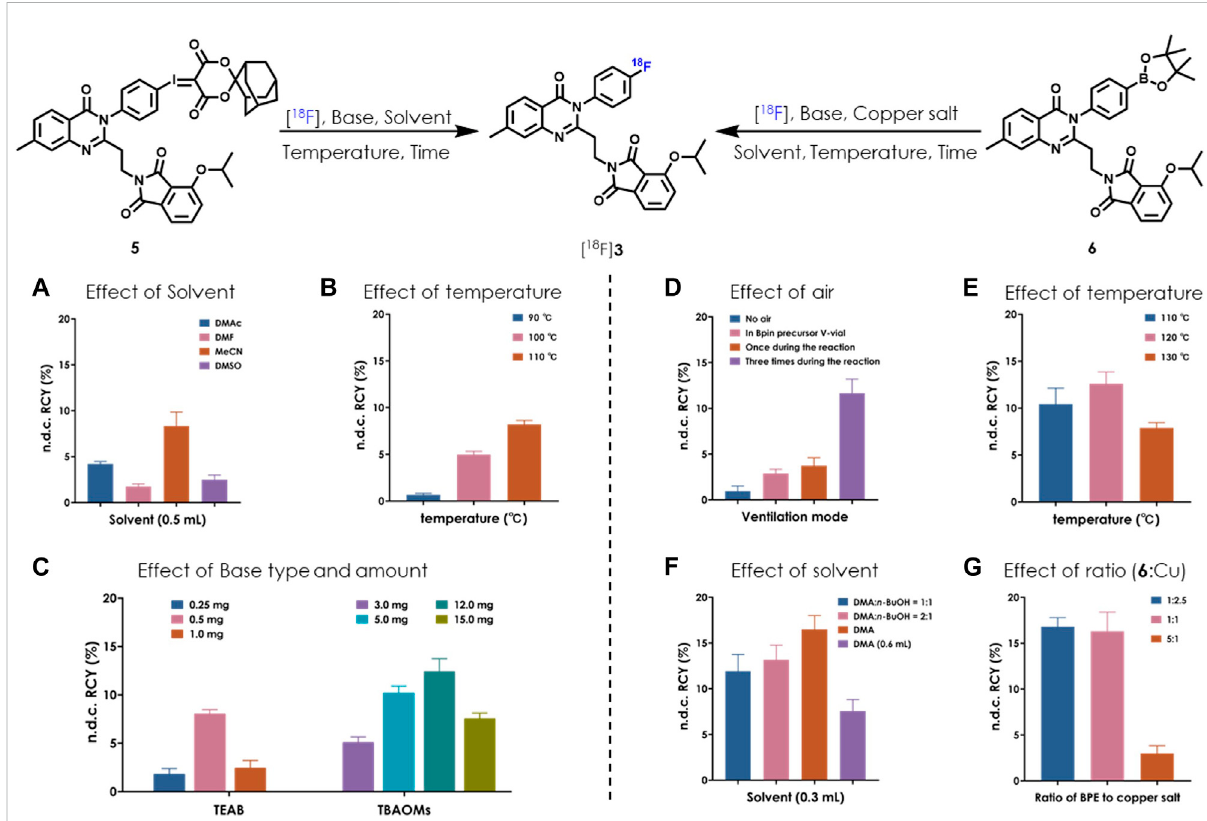
FIGURE 2 Optimization of automatic radiolabeling conditions for [ 18 F] 3 based on SCIDY 5 (A – C) and BPE 6 (D – G) ( n = 3). [ 18 F] fl uoride (14.8 – 18.5 GBq; 400 – 500 mCi) was delivered from the cyclotron to a GE TRACERlab FX2N module in each test. (A) 5 (2 mg), TEAB (0.5 mg), 110 ° C, 10 min; (B) 5 (2 mg), MeCN (0.5 ml), heated for 10 min; (C) 5 (2 mg), MeCN (0.5 ml), 110 ° C, 10 min; (D) 6 (4.25 µmol), Cu(OTf) 2 (py) 4 (10.5 µmol), DMA: n -BuOH (300 μ L,v/v=2/1),TEAB(0.5 mg),120 ° C,20 min; (E)6 (4.25 µmol),Cu(OTf) 2 (py) 4 (10.5 µmol),DMA: n -BuOH(300 μ L,v/v=2/1),TEAB(0.5 mg), heated for 20 min. Air was bubbled into the reaction three times; (F) 6 (4.25 µmol), Cu(OTf) 2 (py) 4 (10.5 µmol), solvent, TEAB (0.5 mg),120 ° C, 20 min. Air was bubbled into the reaction three times; (G) 6 (4.25 µmol), Cu(OTf) 2 (py) 4 (indicated molar ratio), DMA (300 µL), TEAB (0.5 mg), 120 ° C, 20 min. Air was bubbled into the reaction three